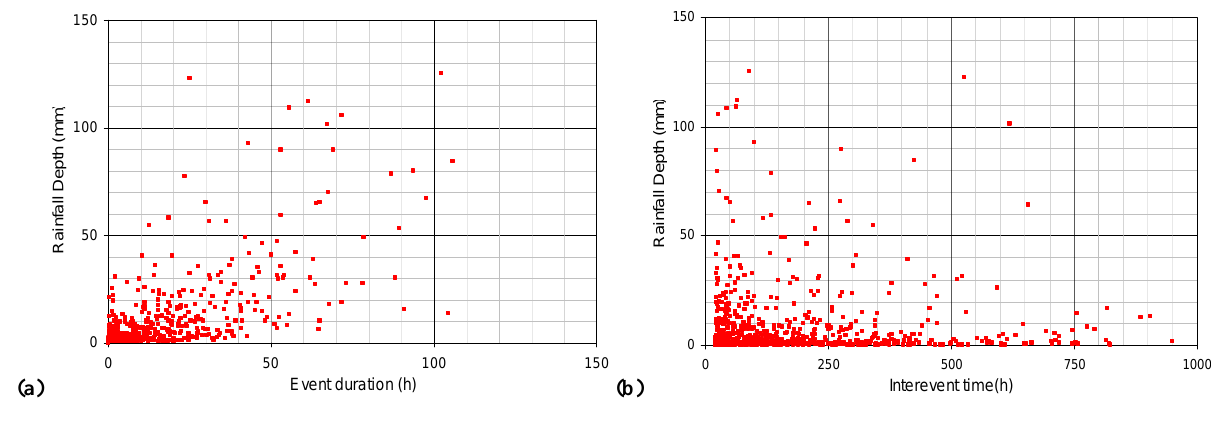
Fig. 5. Scatterplots of v versus d (left) and s (right).